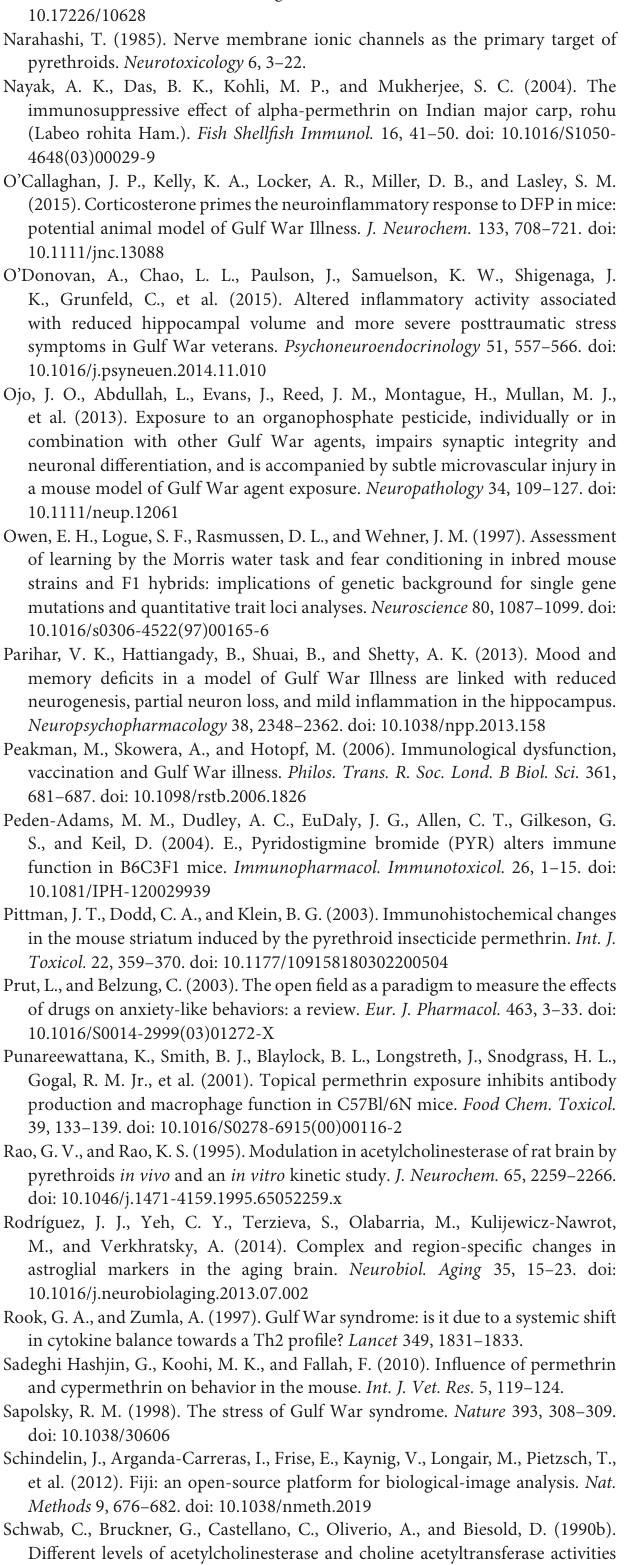
doi: 10.1007/bf01101715 Schwab, C., Brückner, G., Castellano, C., Oliverio, A., and Biesold, D.